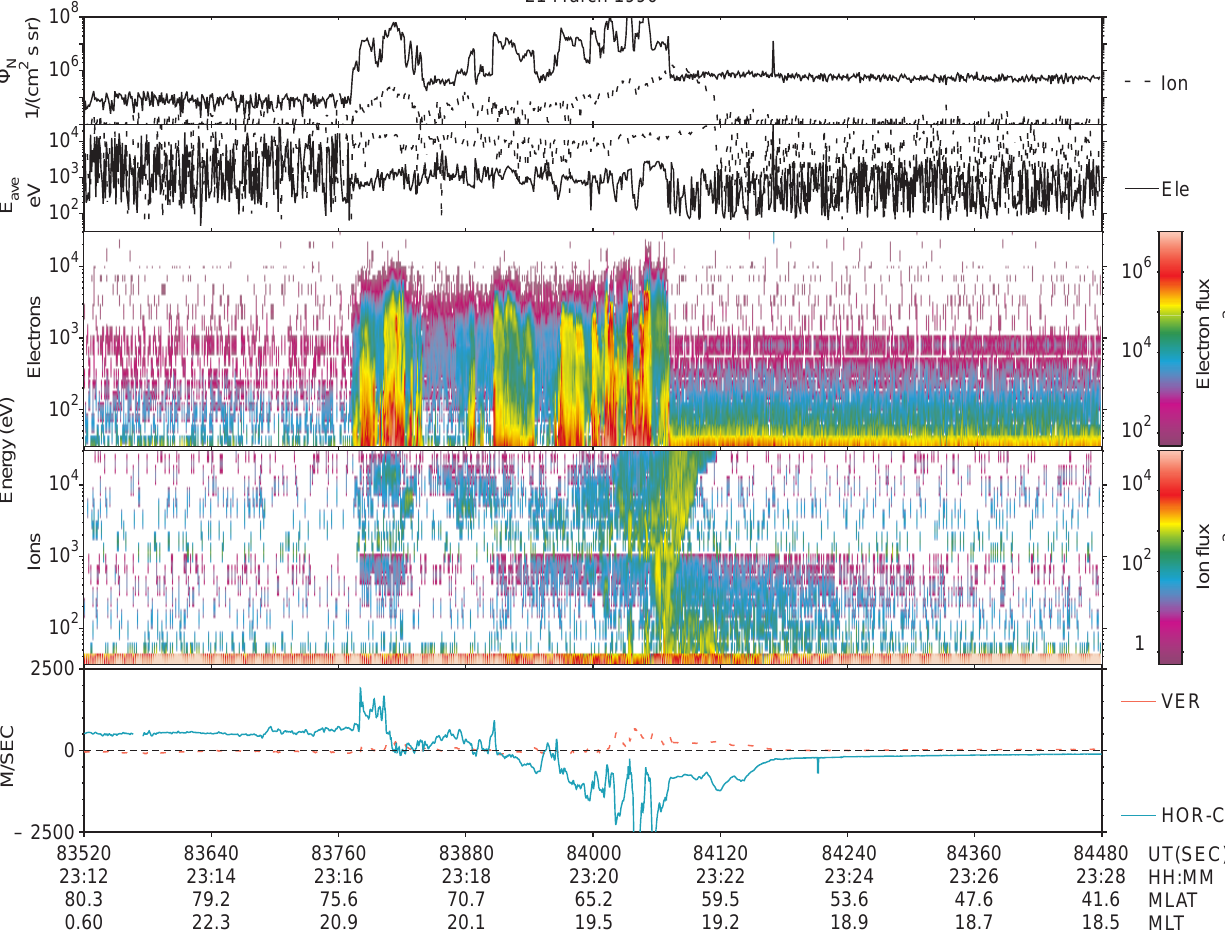
perpendicular to the satellite path in the horizontal plane ( blue line ) and the vertical plane ( red dots ). Several large auroral drift velocity peaks of more than 2500 m/s near 23:21 UT (about 62 : 5 (cid:14) MLAT) and the SAID peak of about 1200 m/s near 23:22 UT (about 59 : 5 (cid:14) MLAT) are